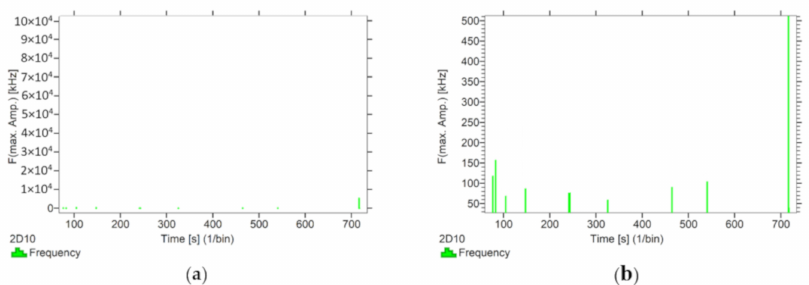
Figure 10. Frequency distribution graph during the test for the mock BM sample: ( a ) taking into account the entire frequency range; ( b ) specifying the frequency range before destruction.